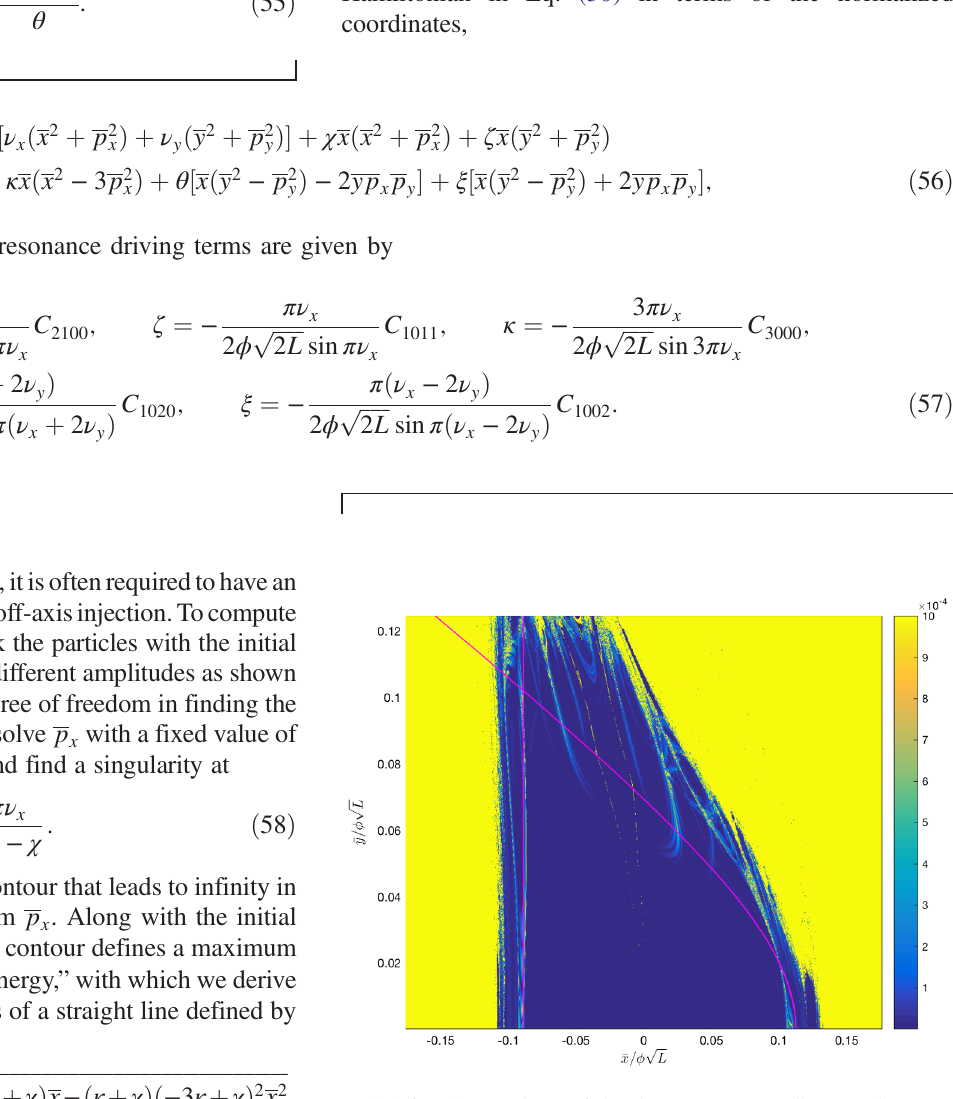
FIG. 16. Comparison of the theory (magenta lines) at betatron 0 . 28 , ν 0 . 31 and the frequency map by tracking tunes ν x ¼ y ¼ using the symplectic maps with the cell length L ¼ 15 m and angle ϕ ¼ π = 96